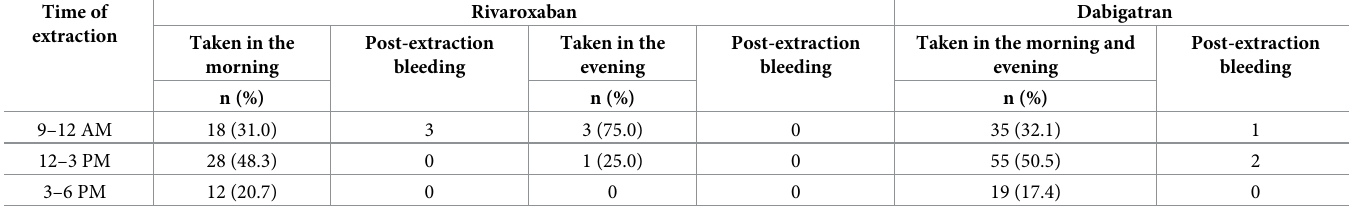
Table 6. Incidence of clinically significant post-extraction bleeding according to the timings of direct oral anticoagulant administration and tooth extraction. Time of